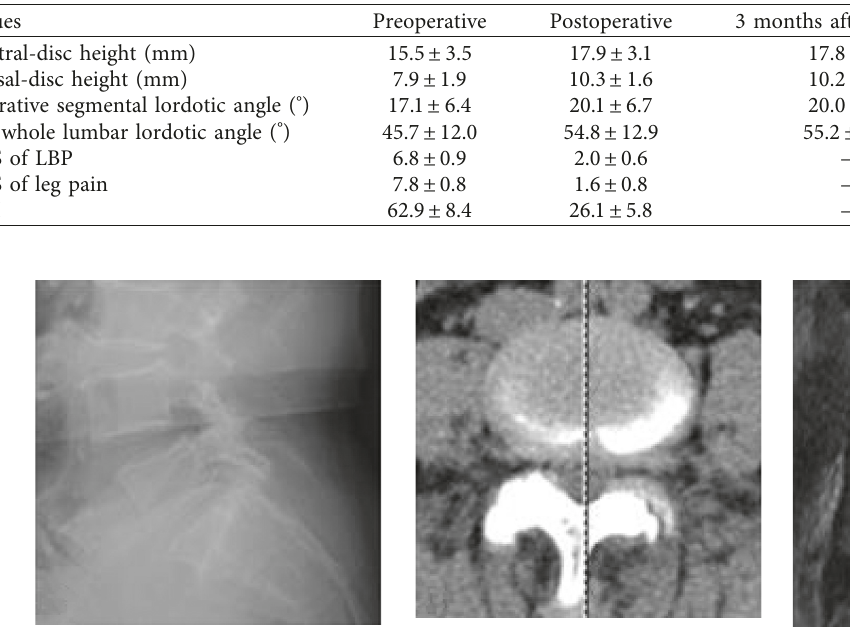
Table 2: Radiological and clinical